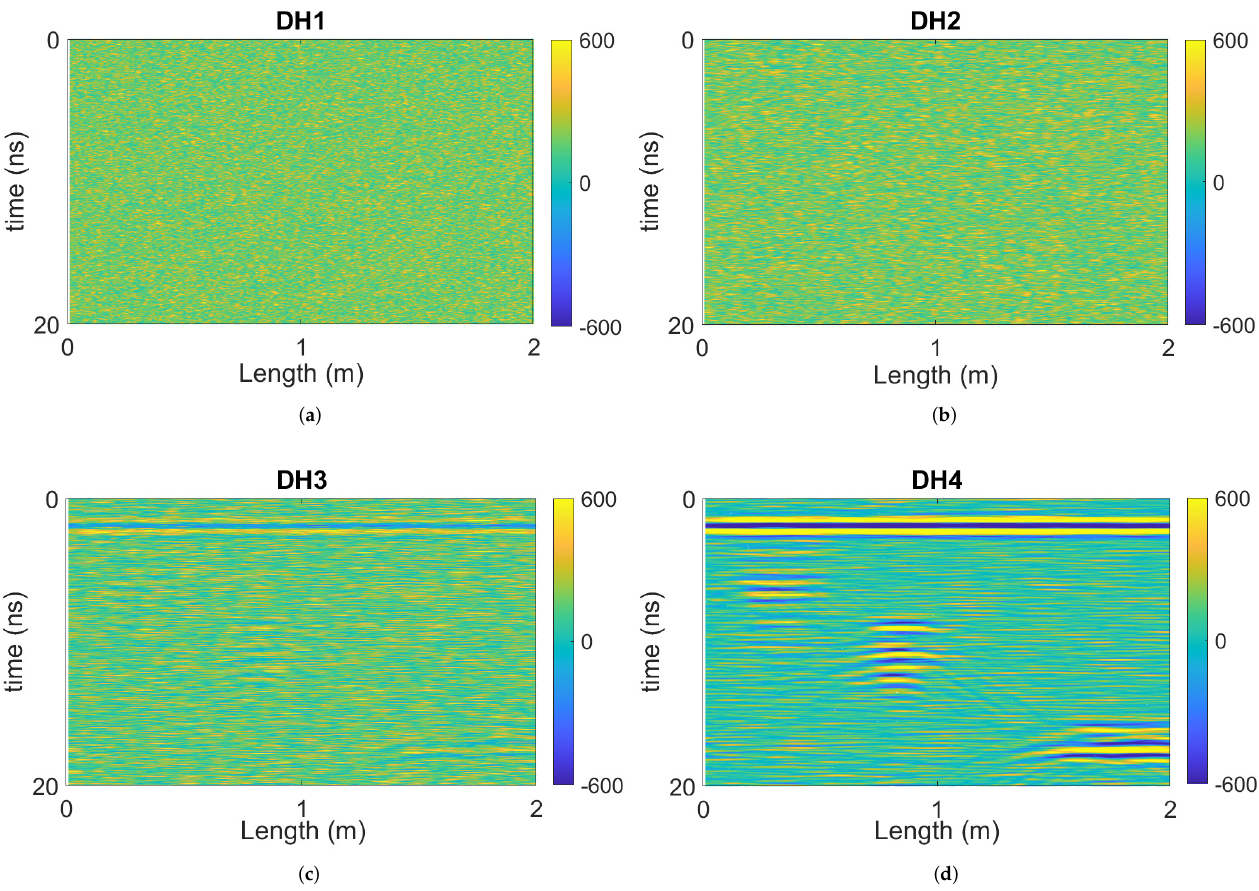
Figure 14. The horizontal detail coefficients of ( a ) 1st-layer DH 1 , ( b ) 2nd-layer DH 2 , ( c ) 3rd-layer DH 3 , and ( d ) 4th-layer DH 4 .